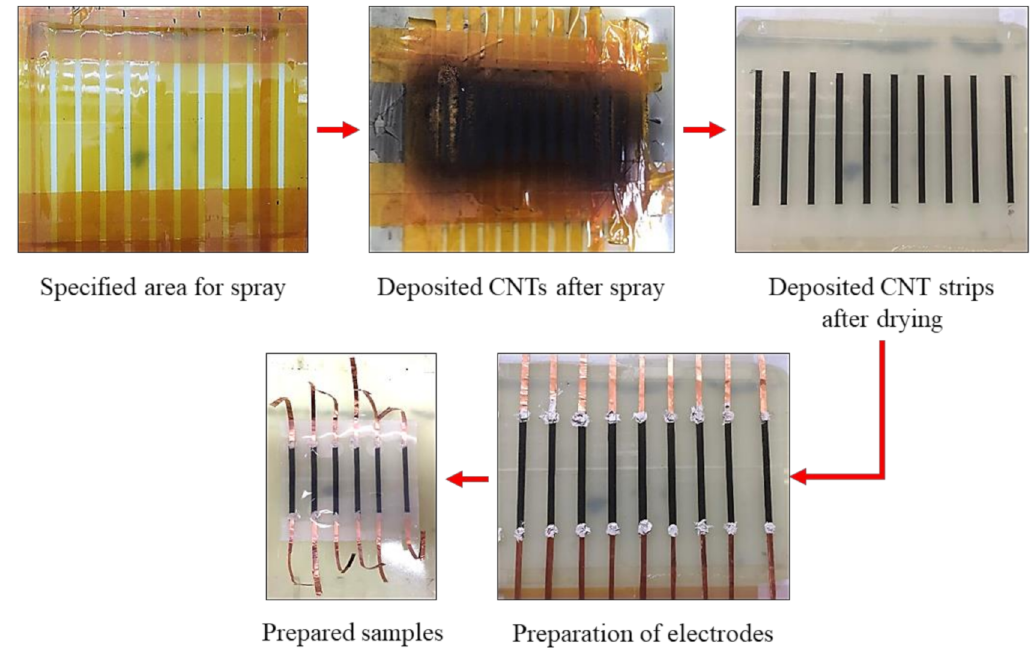
Figure 1. Fabrication process of sprayed CNT layer-embedded